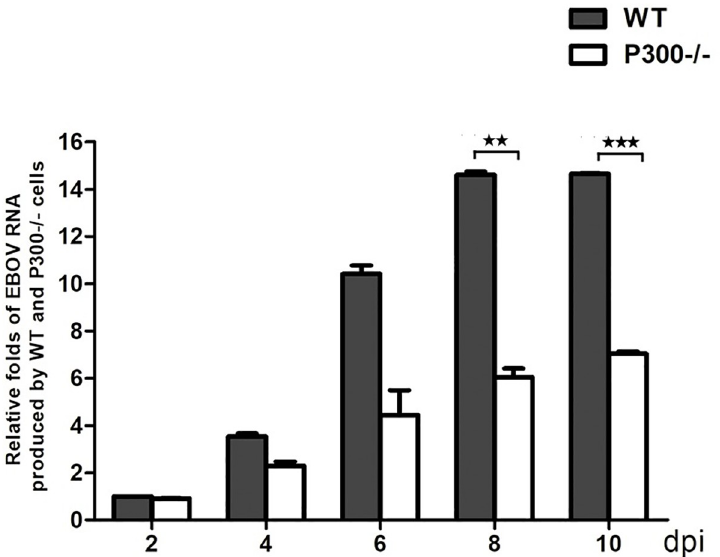
Fig 7. Zaire ebolavirus production is lessened in P300 KO cells. HEK293T WT cells and P300 KO cells were infected with the Zaire ebolavirus at a multiplicity of infection (MOI) of 1. Aliquots of supernatant fluids were taken at days 2, 4, 6, 8 and 10 for the viral RNA qPCR